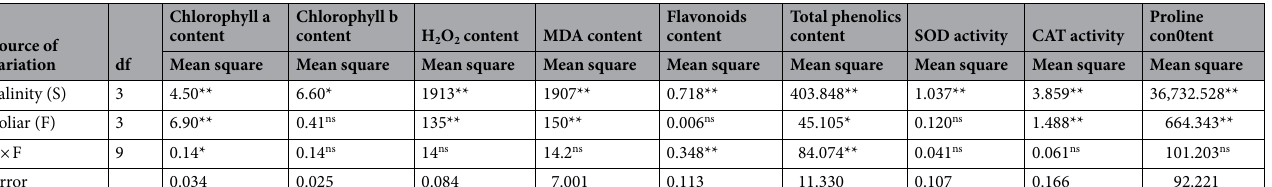
Table 4. ANOVA for the effects of salinity (0, 50, 100, and 150 mM NaCl) and foliar applications (no-foliar, KNO 3 , glucose, and Dobogen) on the chlorophyll a and b, total phenolics, flavonoids, proline, H 2 O 2, and MDA content as well as on SOD and CAT activity of Tanacetum balsamita plants grown hydroponically in perlite. df, degree of freedom; SOD, Superoxide dismutase; CAT, Catalase; ns, non-significant. *Significant difference at P ≤ 5%, and **Significant difference at P ≤ 1%, following two-way ANOVA.